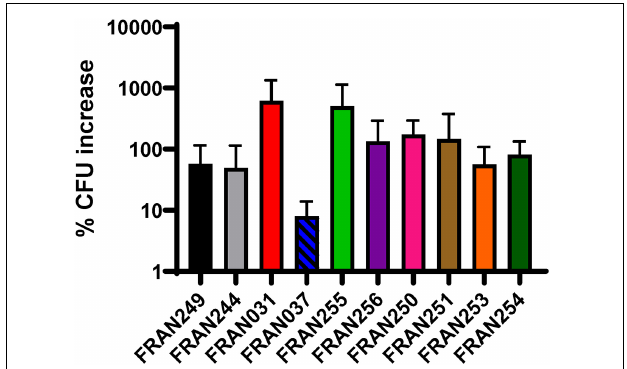
FIGURE 6 | Intracellular replication of F. tularensis strains in J774.1 macrophages. Gentamicin protection assays were utilized to assess replication of F. tularensis strains in J774.1 murine macrophages. Macrophage monolayers were infected with an MOI of 100 and cells were lysed and plated to enumerate CFU at 4 and 24 h post-infection. The percent CFU increase from the 4 h to 24 h time point was calculated. No statistical significance in percent increase was observed via t